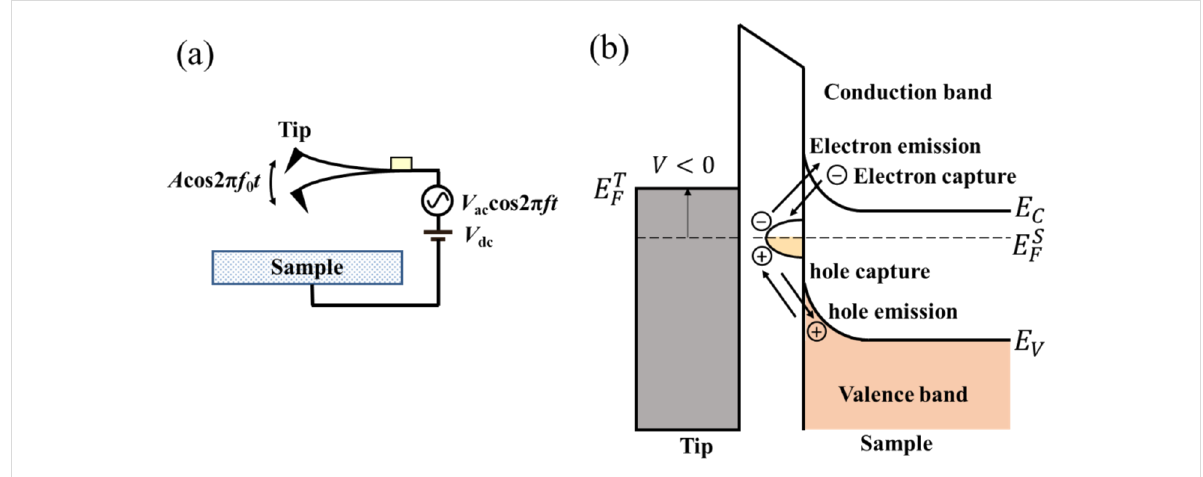
Figure 1: (a) Schematic of the metal tip–gap–semiconductor sample. (b) Energy band diagram of the metal–gap–semiconductor sample. Emission and capture of carriers (electrons and holes) occur between the interface and bulk states of the semiconductor sample when a low-frequency AC bias voltage is